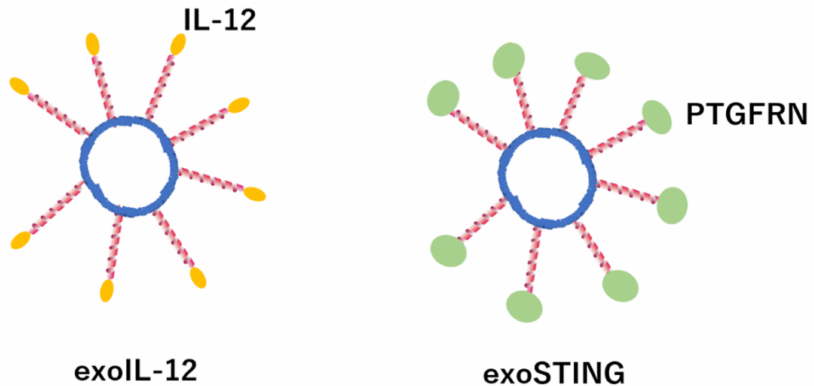
Figure 2. exoIL-12 is improved exosome expressed IL-12 on surface of exosome. ExoSTING in improved exosome encapsulating a STING agonist in exosomes, in which a therapeutic protein such as prostaglandin F2 receptor negative regulator (PTGFRN), is highly expressed in the exosome